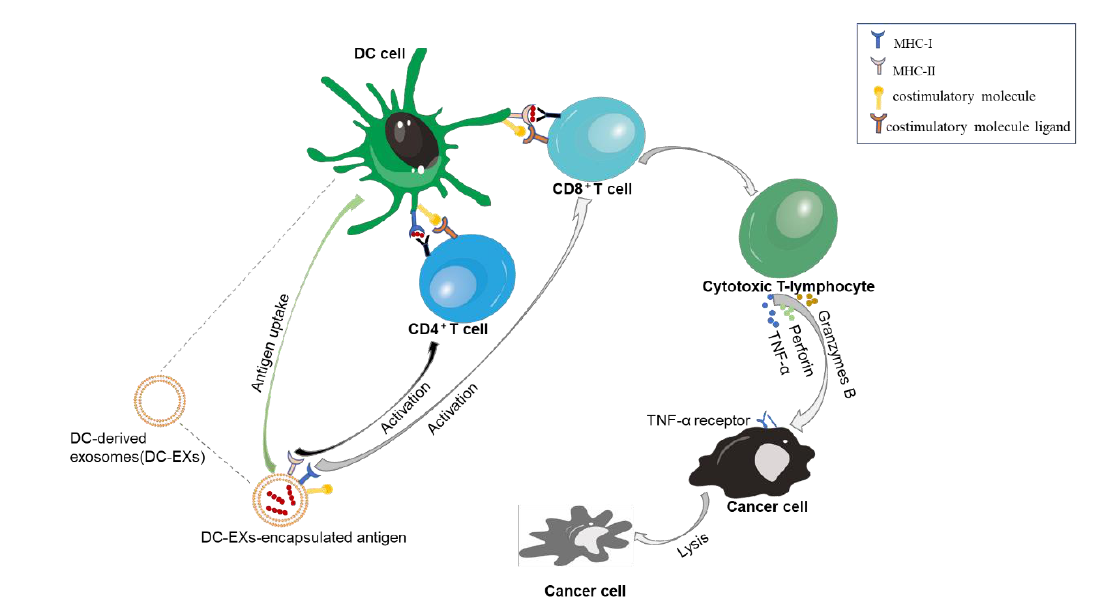
Figure 5. DC-EX-based vaccines induce an anti-cancer immune response in vivo. Cancer-specific antigens are loaded into DC-EXs to form an anti-cancer vaccine. DC-EXs can express MHC-I, MHC-II and T cell costimulatory molecules. Therefore, they can present antigens to CD8 + and CD4 + T cells, and induce the activation of specific T cells and a strong CTL response. Then, CTLs release granzyme B, perforin and TNF-α to efficiently kill cancer cells. DC-EXs, DC-derived exosomes; MHC-I, major histocompatibility complex class I; MHC- Ⅱ , major histocompatibility complex class Ⅱ .